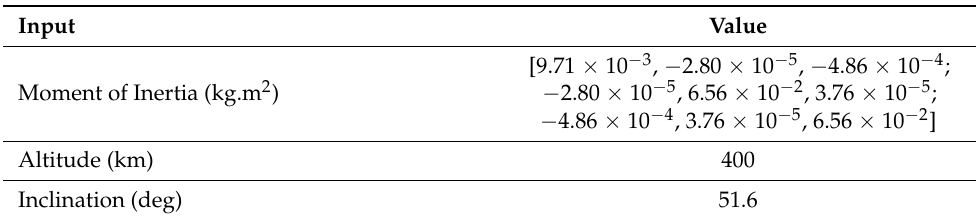
Table 8. Input values used to run the detumbling